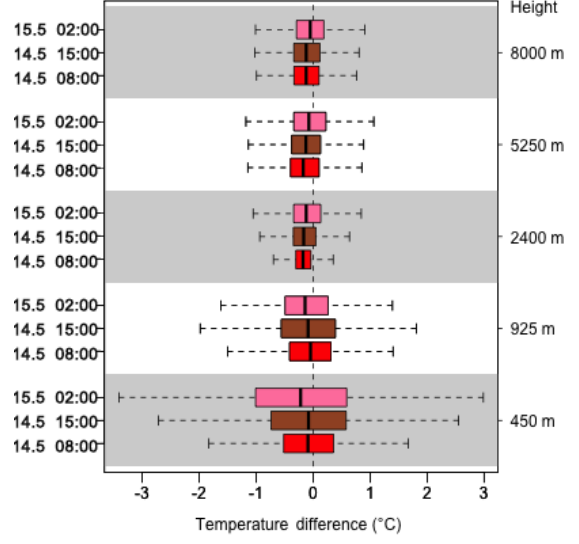
Figure 11. Temperature differences between HR and HR_RESHIFT in domain 2.